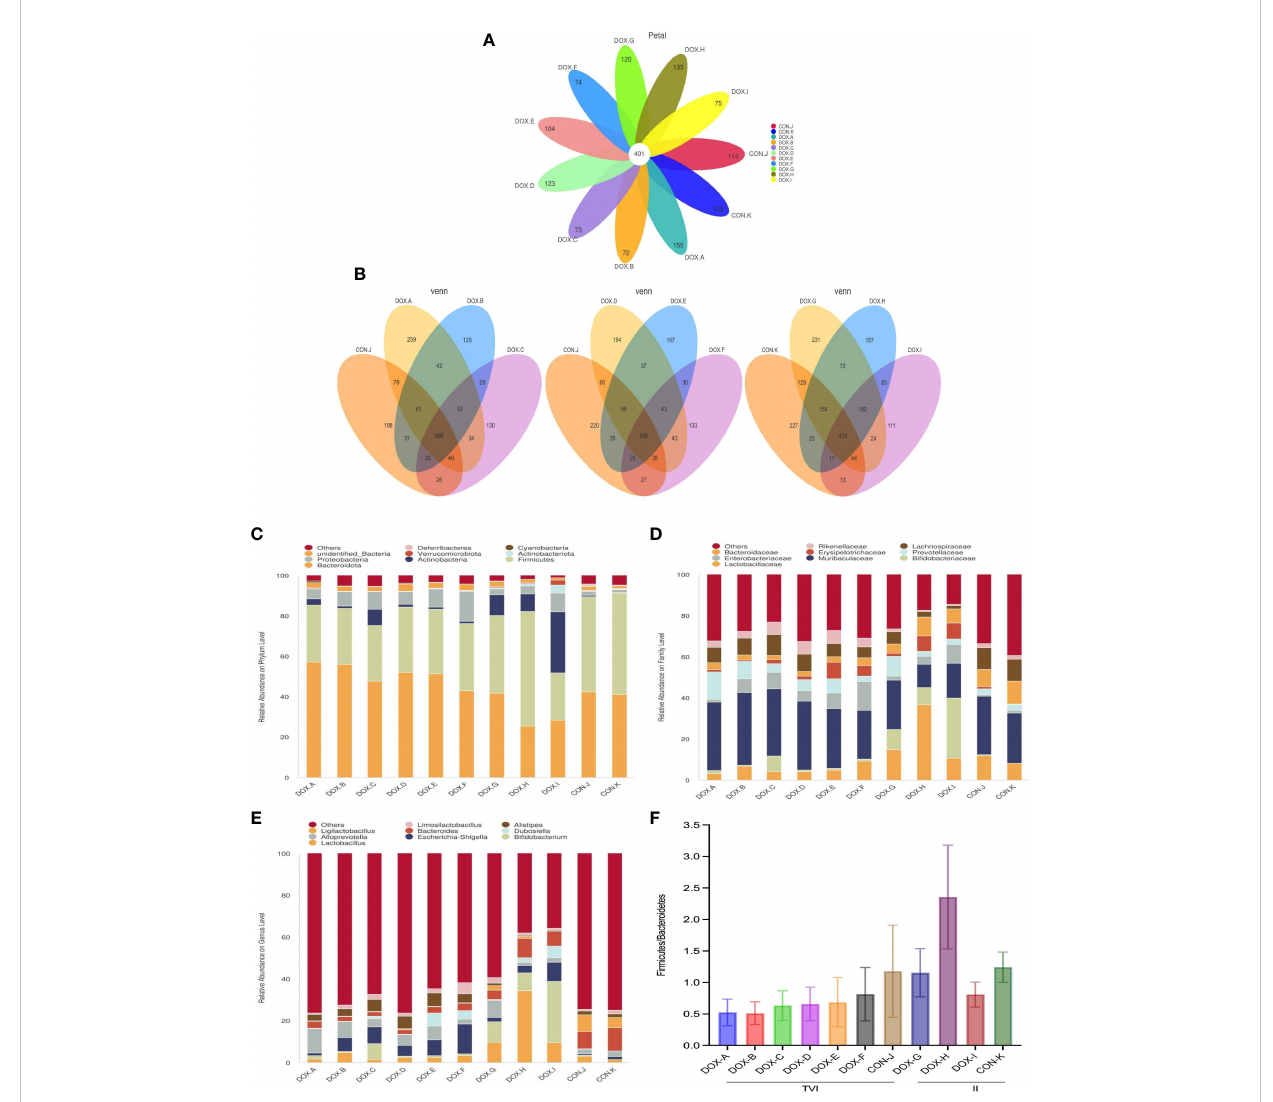
FIGURE 5 OTU analysis and compositionof the gut microbiota. (A) Petal diagram. (B) Venn diagram.*Each circle in the Petal or Venn diagram represent a group of samples. The number of circles and overlapped parts represents the number of OTUs shared between the sample groups, and the number without overlapped parts represents the number of OTUs unique to the sample group. (C – E) Relative abundance of microbial community from each group of rat at phylum, family, and genus levels. (F) The ratio of Firmicutes: Bacteroidetes (F/B) at the phylum level.CON,control; DOX, doxorubicin. n =